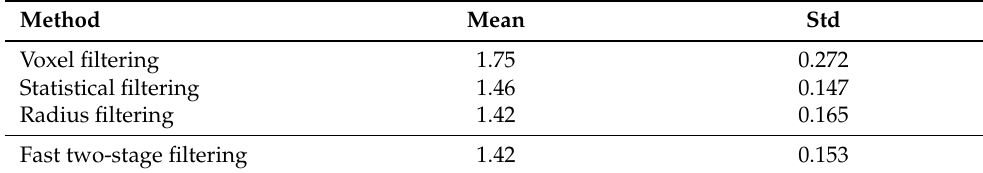
Table 1. Comparison of reconstruction accuracy of mesh on synthetic data using point-to-plane distance with different filtering methods. The table reports the mean error (Mean) and the standard deviation